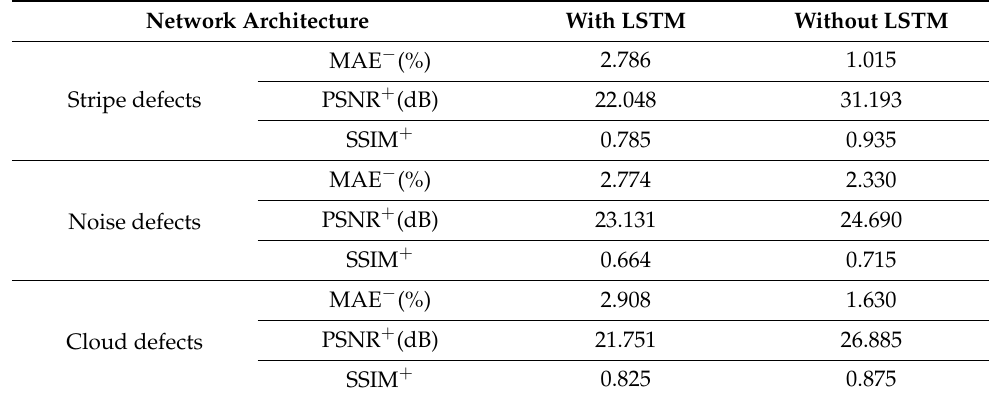
Table 8. Inpainting Quality Comparison of LPIN with or without LSTM.